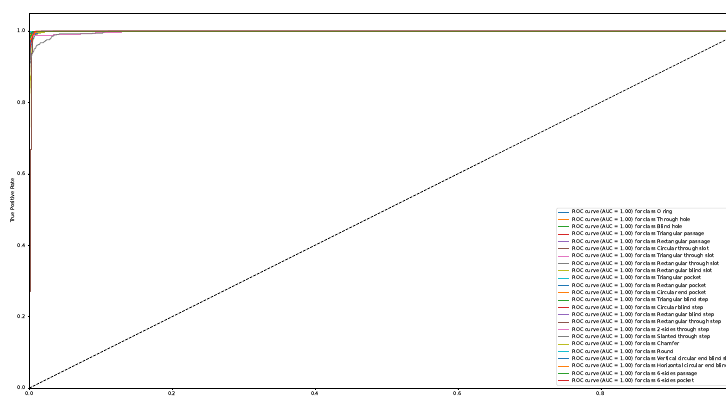
Figure A9. ROC curve for FeatureNetLite.